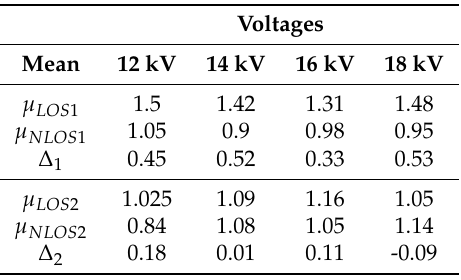
Table 5. Mean of the overall rate of traffic for all voltages in different